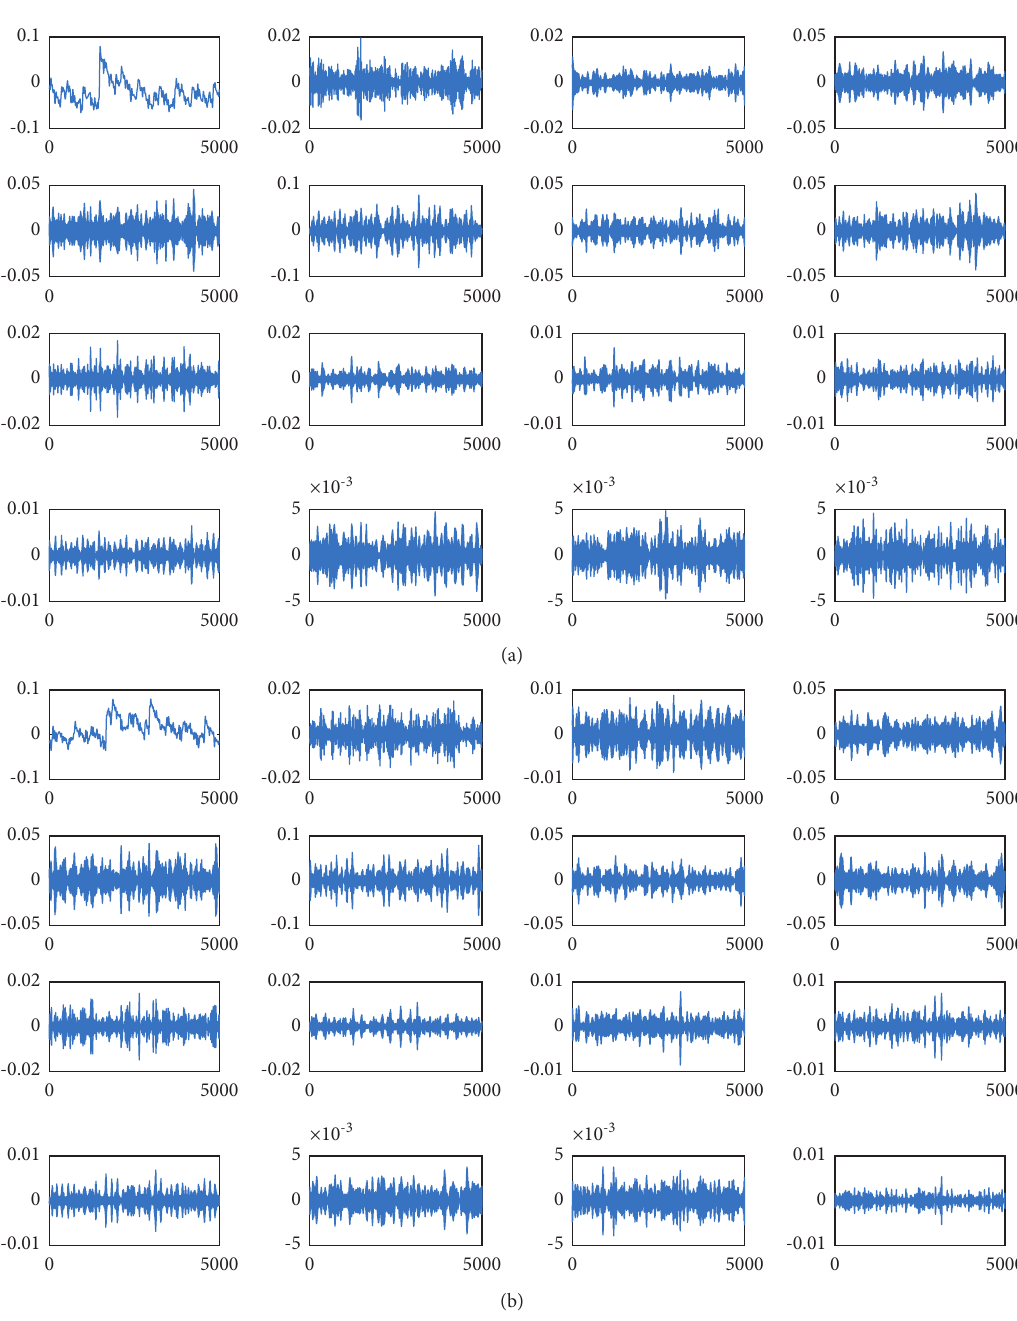
Figure 9: Reconstruction signals for wavelet packet nodes obtained by decomposing normal state vibration signals. (a) The reconstruction signals of NM signal under 1730rmp by MODWPT. (b) The reconstruction signals of NM signal under 1750rmp by